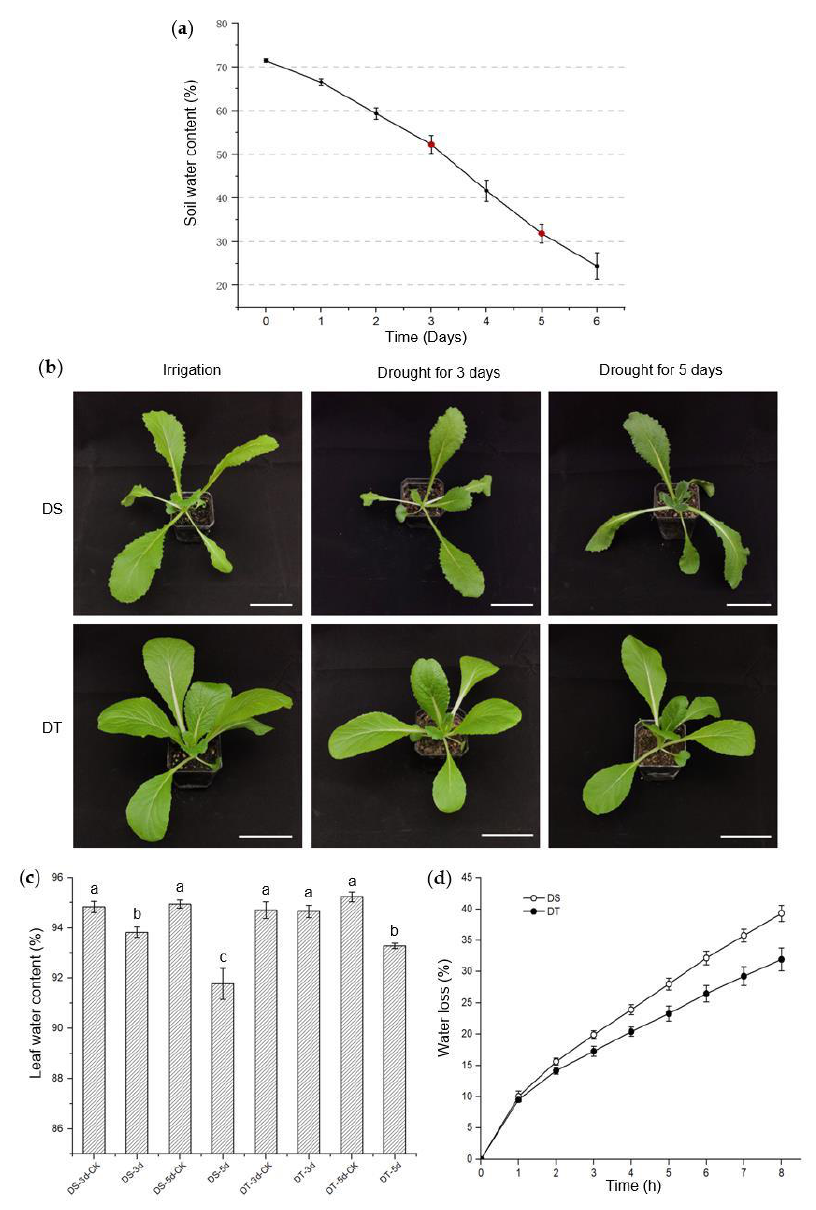
Figure 1. Phenotypic screening and investigations of drought − susceptible (DS) and drought − tolerant (DT) genotypes. ( a ) Soil water content during drought stress. Sampling time labeled in red; ( b ) Morphology of DS and DT after 3 and 5 days without watering. Scale bars, 7 cm; ( c ) Leaf water content of DS and DT after 3 and 5 days without watering. Statistical differences are indicated with lowercase letters determined by Duncan’s test at P < 0.05. ( d ) Water loss of DS and DT. All data are shown as means ± SE with three independent biological replicates.